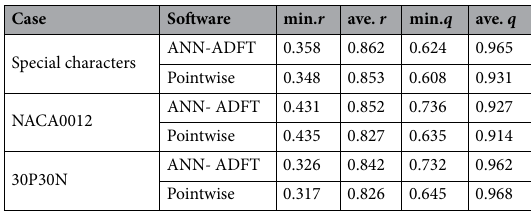
Table 1. Quality statistics of 2D triangular meshes.